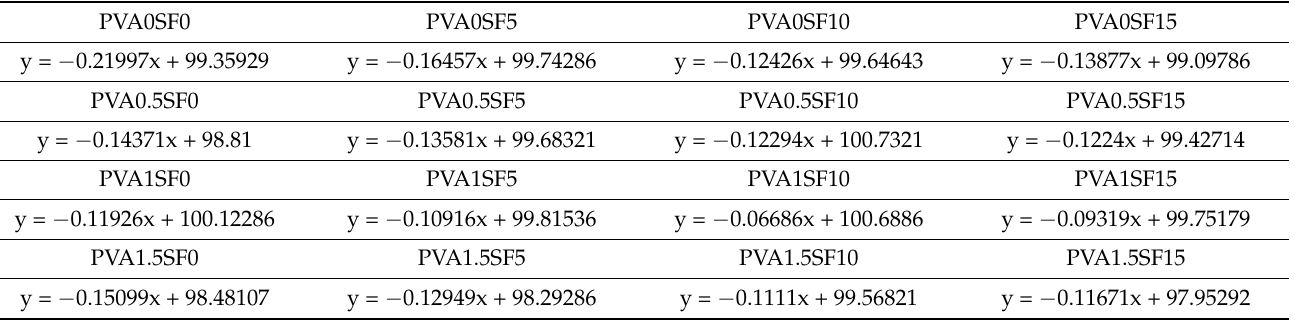
Table 3. Contribution rate regression